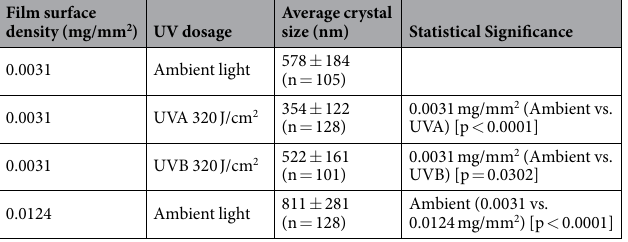
Table 1. DNA Film Crystal size variation with surface density and UV irradiation. Crystal size measurements for each surface density and UV dosage are extracted from a minimum of n = 2 films. Statistical differences in